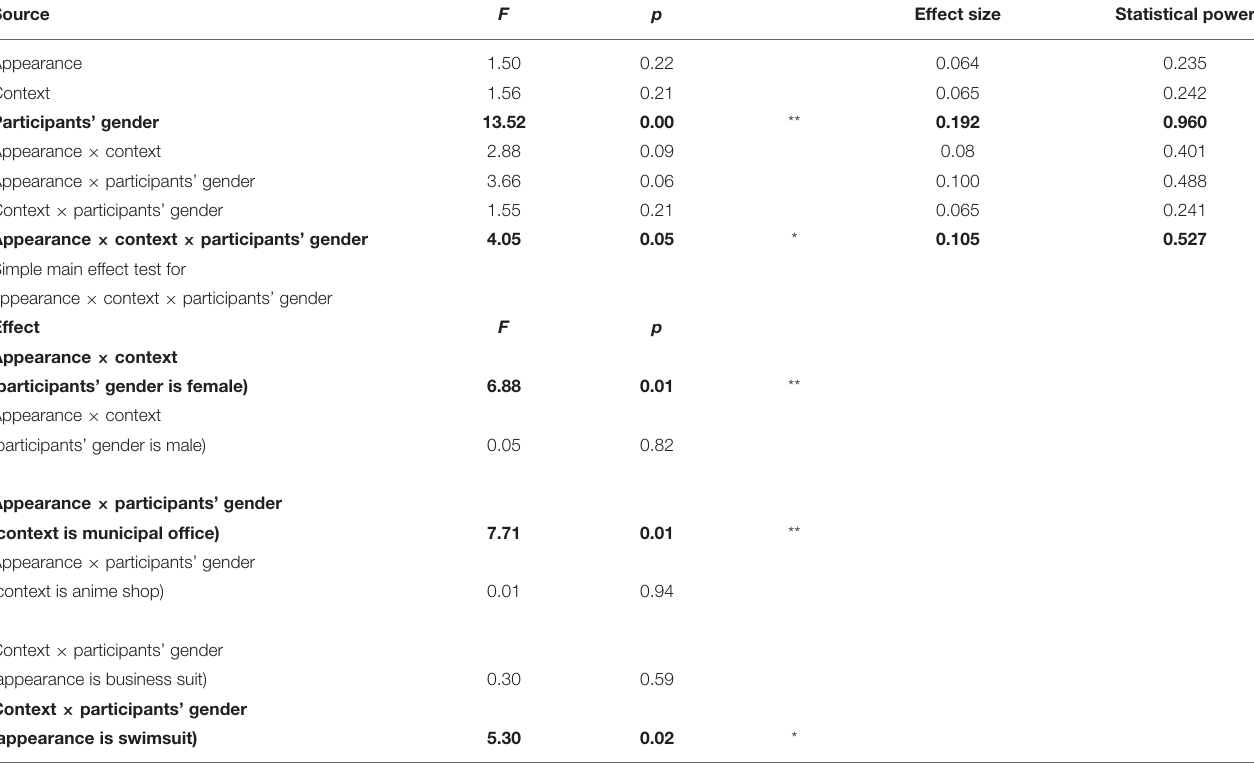
TABLE 7 | Results of three-way ANOVA and simple main effect test for appearance × context × participants’ gender for Q3 (likability). Source F